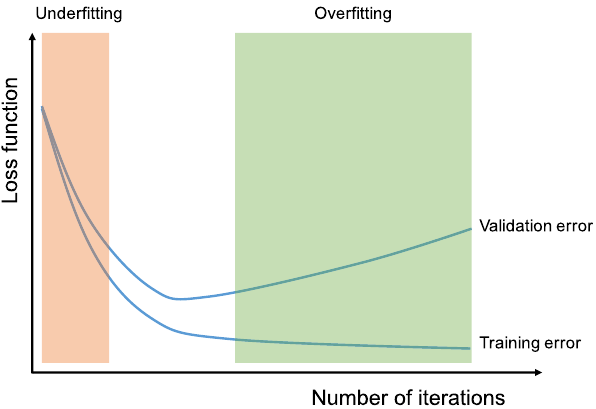
Fig. 9 A routine check for recognizing overfitting is to monitor the loss on the training and validation sets during the training iteration. If the model performs well on the training set compared to the validation set, then the model has been overfit to the training data. If the model performs poorly on both training and validation sets, then the model has been underfit to the data. Although the longer a network is trained, the better it performs on the training set, at some point, the network fits too well to the training data and loses its capability to generalize